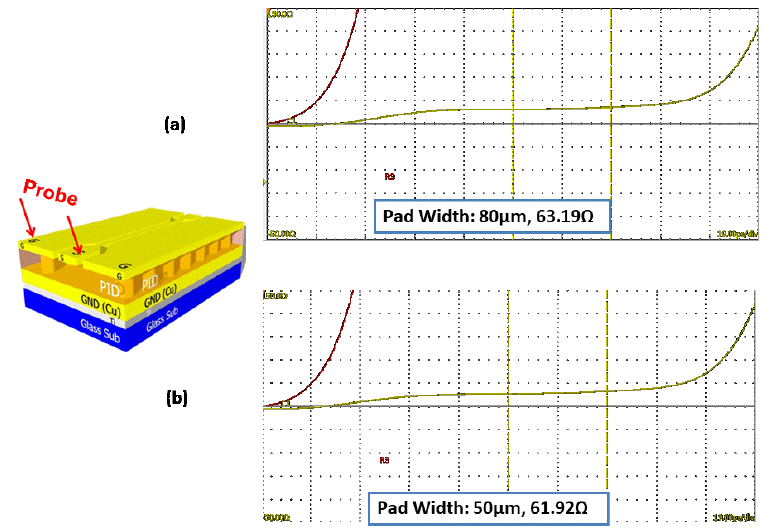
Figure 14. Cross-section images.